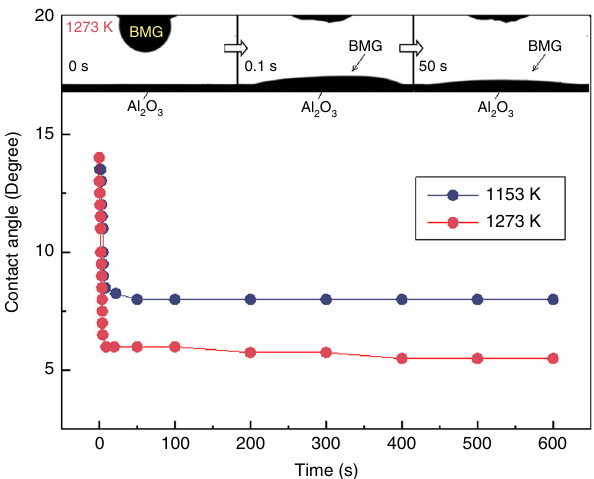
Fig. 2 Rate and extent of wetting of bulk-metallic glass on alumina. Wetting angles, measured using a sessile-drop experiment, at temperatures of 1153 and 1273 K. The wetting angles, when plotted with respect to time, show that the contact angle converges on 8° at 1153 K and 6° at 1273 K within 10 s. This is a strong indication that the wetting kinetics are independent of any potential reaction occurring at the interface between the metal melt and the ceramic solid